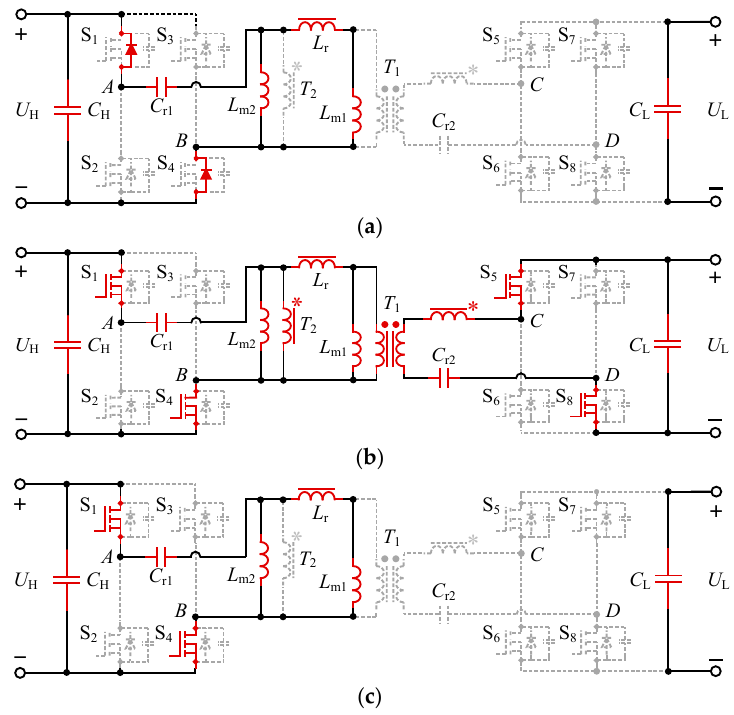
Figure 3. Equivalent circuits for each stage in forward mode: ( a ) Mode A; ( b ) Mode B; ( c ) Mode C.